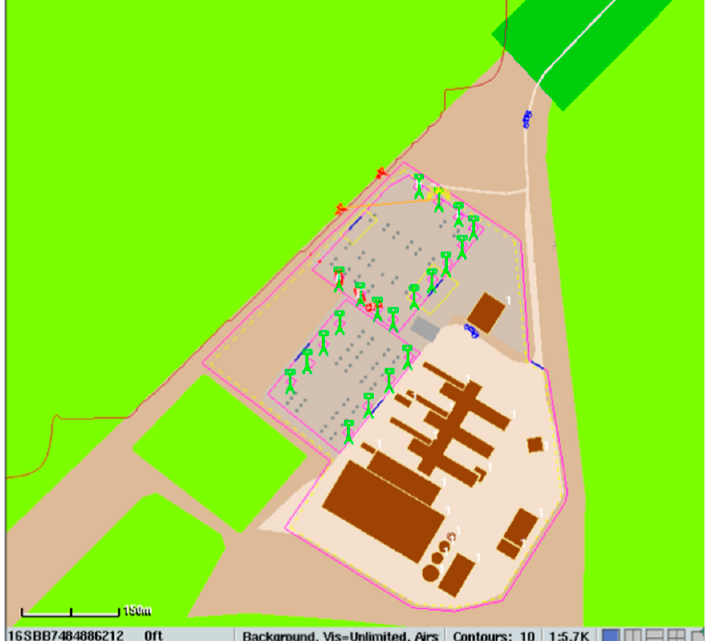
Figure 4. Elite Attackers (red) in a Cyber-Enabled Physical Attack, LLNL-PRES-746039.